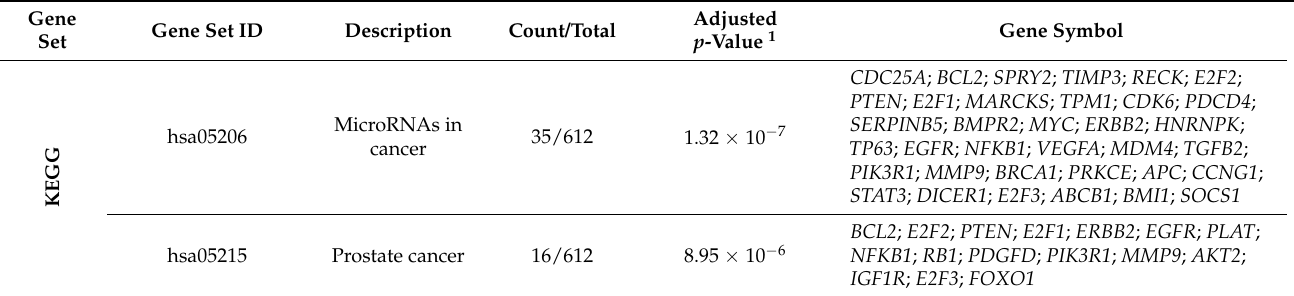
Table 1. Functional enrichment analysis of miR-21 in prostate cancer. Table shows the significant association of miR-21 target genes with Gene Set descriptions related to prostate cancer. Analysis performed using clusterProfiler in